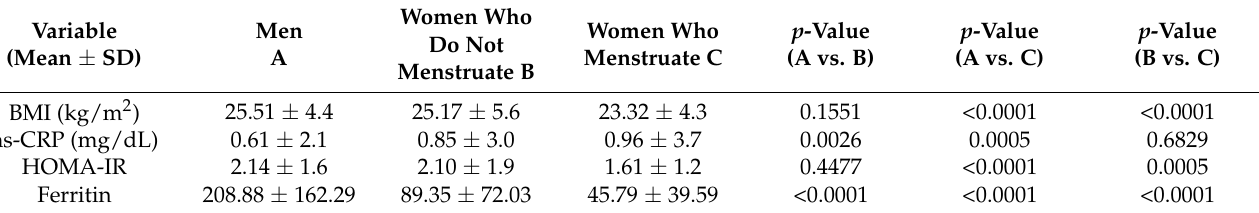
Table 1. Descriptive parameters of the study groups.